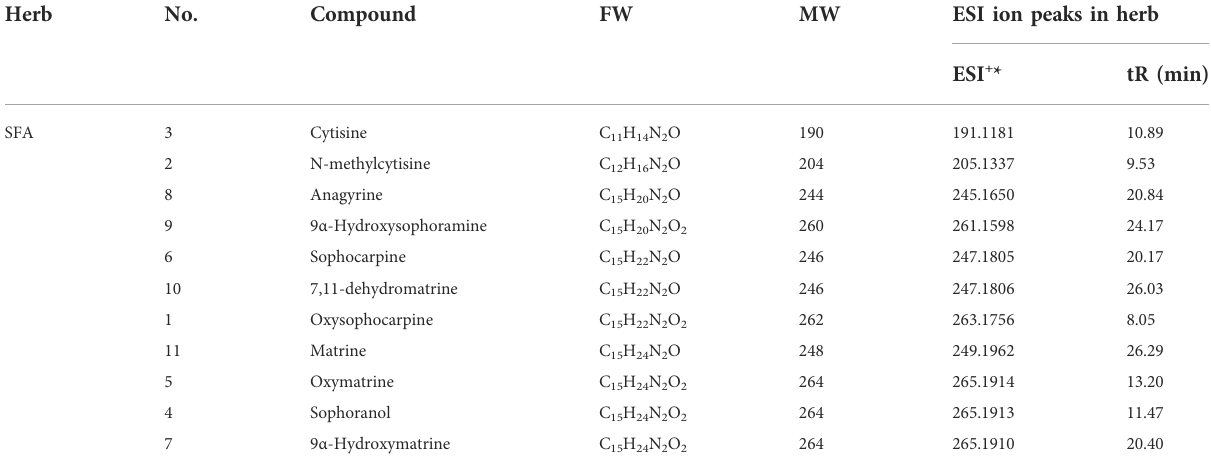
TABLE 1 ESI ion peaks elucidated from the HPLC-MS spectra of the SFA decoction.